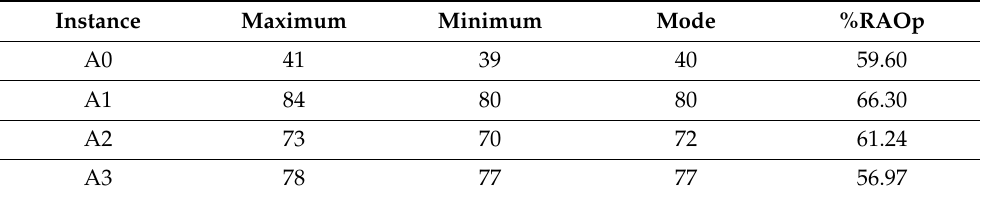
Table 10. ILS results for each benchmark instance consuming 2 h of processing time.